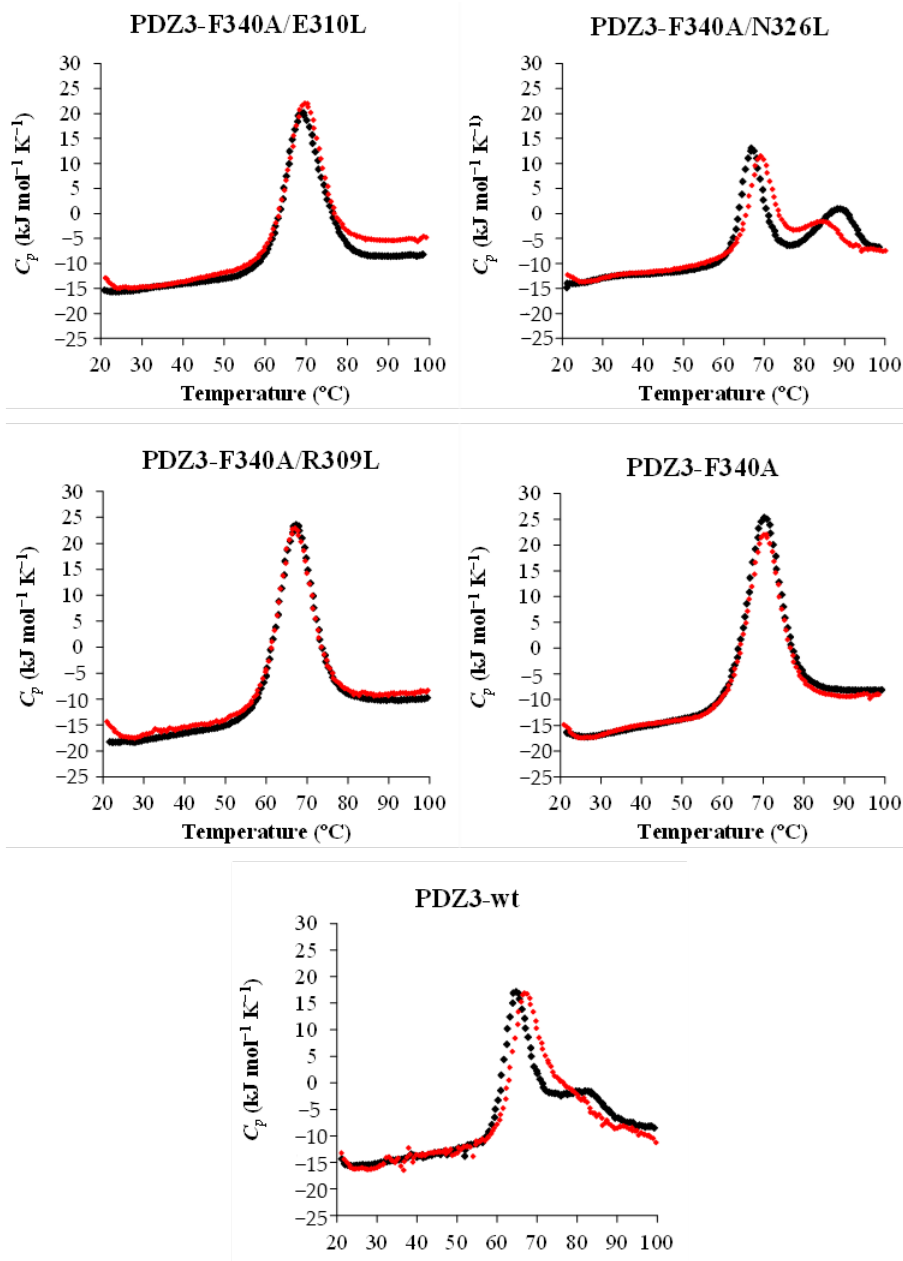
Figure 3. Concentration dependence of DSC thermograms of PDZ3 variants at 0.5–1 mg/mL, pH 7.5, and 1 °C/min scan rate. Black and red dots show DSC thermograms at a protein concentration of 1 and 0.5 mg/mL, respectively. Table 3. Thermodynamics parameters were calculated by DSC measurements at 0.5–1 mg/mL of protein concentration .